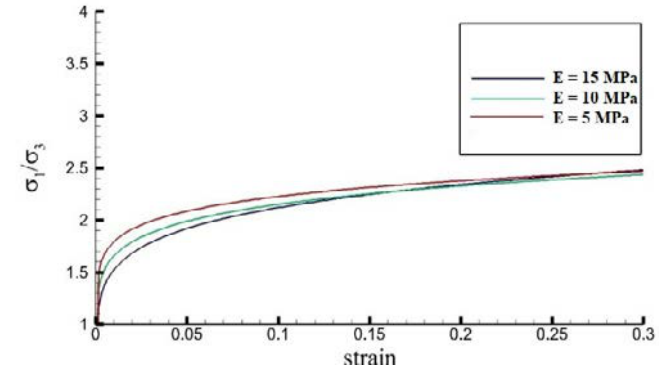
Fig. 2: Stress-strain diagram for MSW without fiber at confining stress es of 100 , 2 00 , and 3 00 kPa Fig. 2: Stress‐strain diagram for MSW without fiber at confining stresses of 100, 200, and 300 kPa